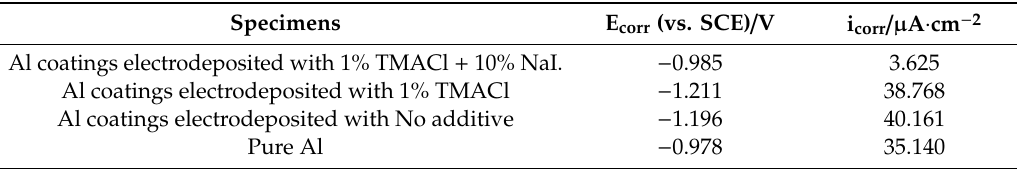
Table 2. Electrochemical parameters calculated from the potentiodynamic polarization curves in 3.5 wt.% NaCl